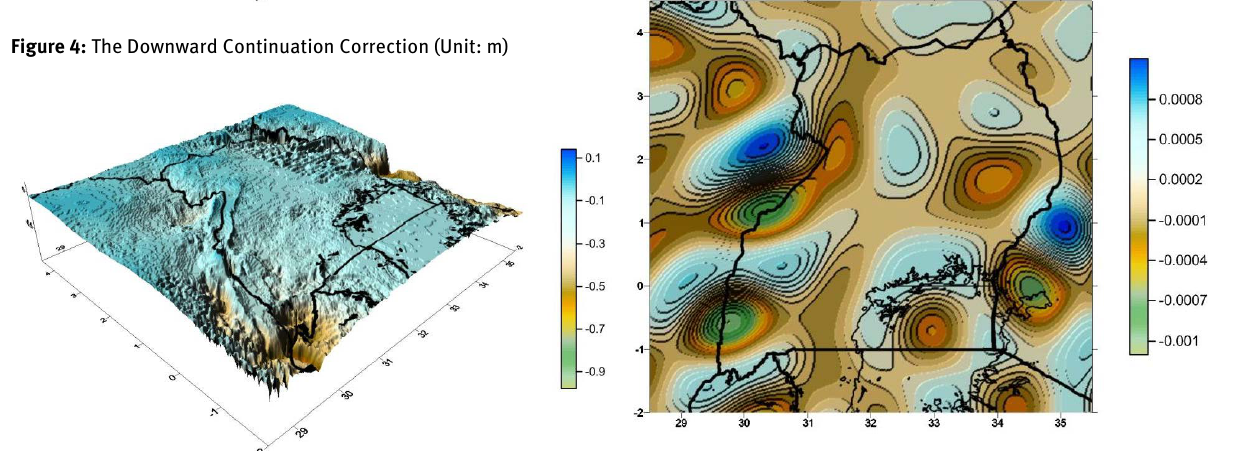
Figure 7: The ellipsoidal correction (units: